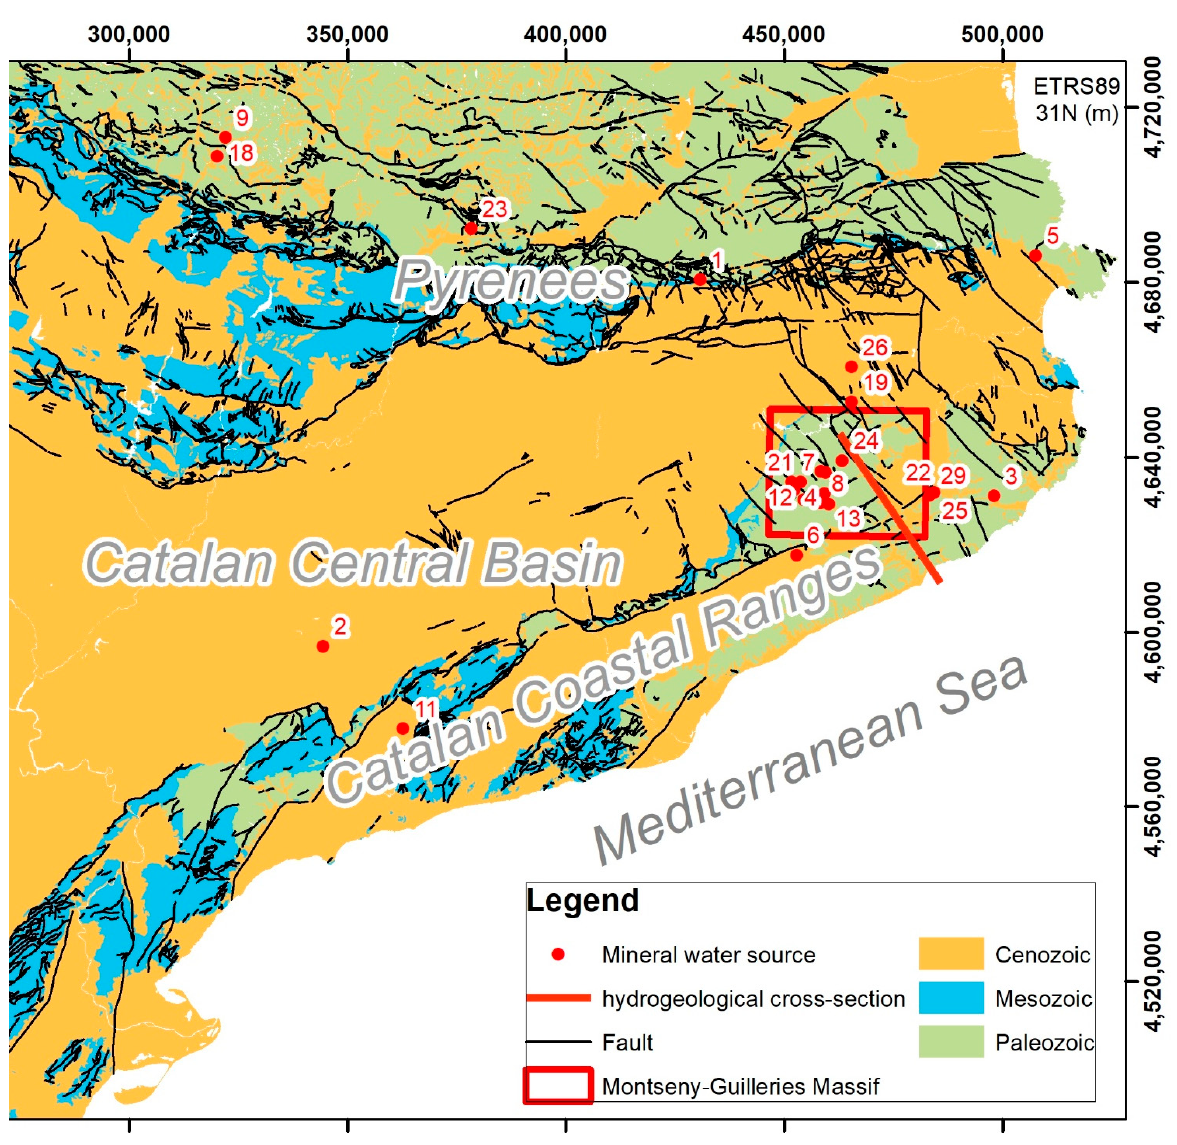
Figure 1. Simplified geological map showing the analysed mineral waters sources and the location of Figure 2 hydrogeological cross-section. Geological base map modified from [23].